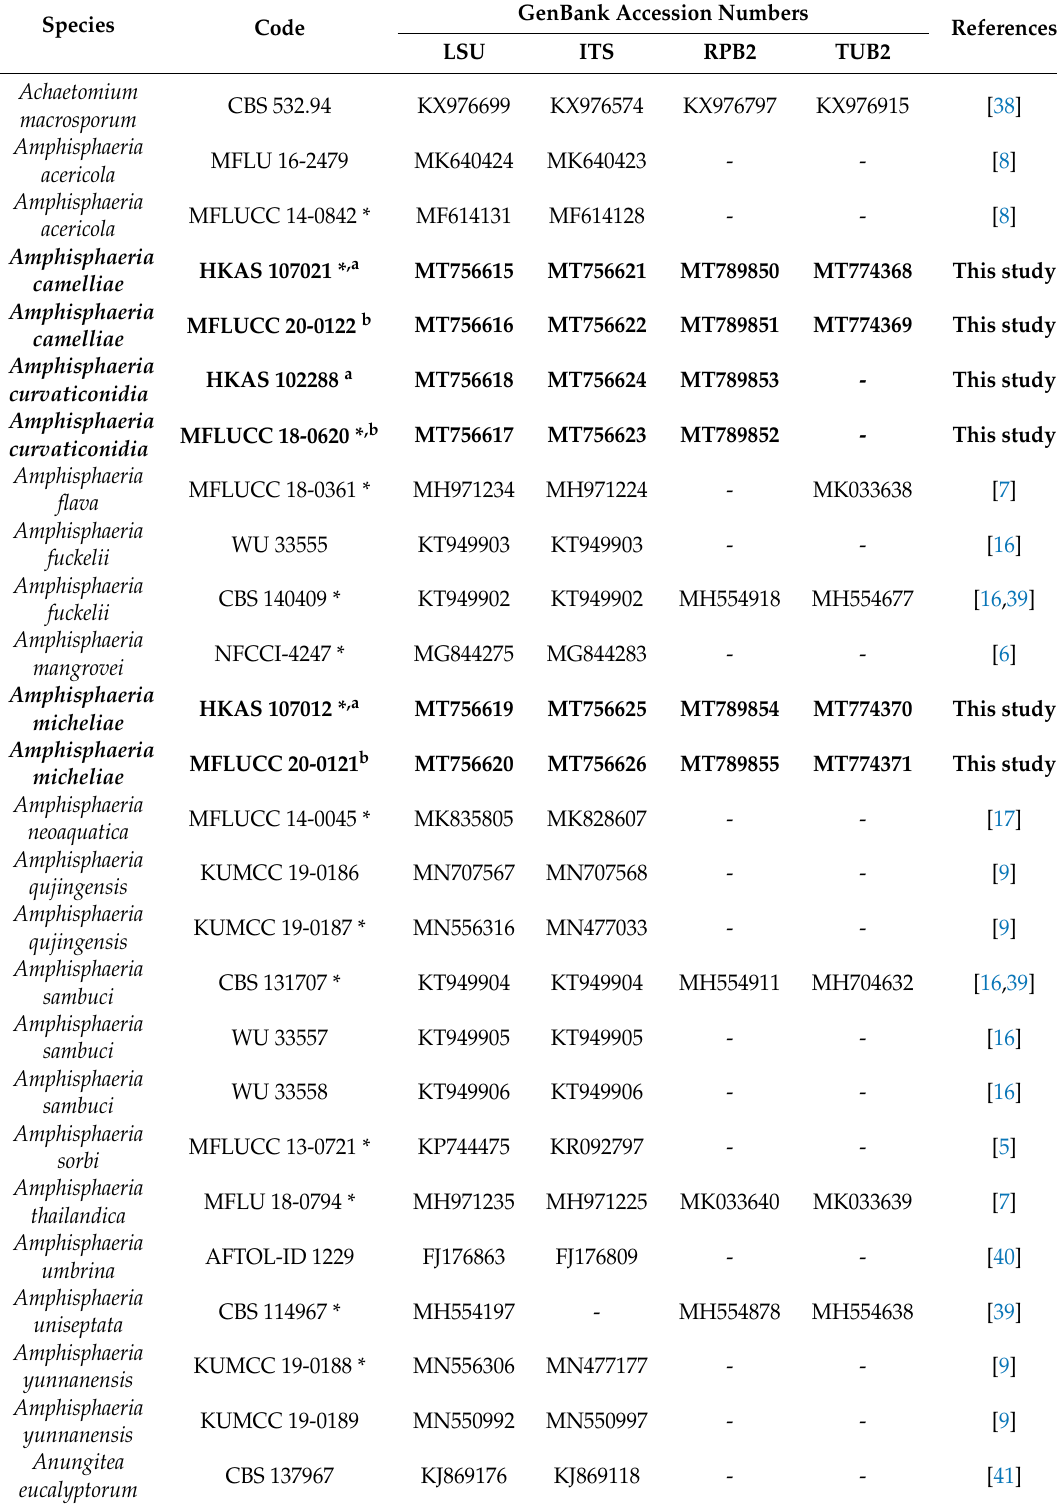
Table 1. List of taxa used in the current phylogenetic study and GenBank acc. nos of DNA sequences. Strains and corresponding sequences that were newly obtained are printed in bold